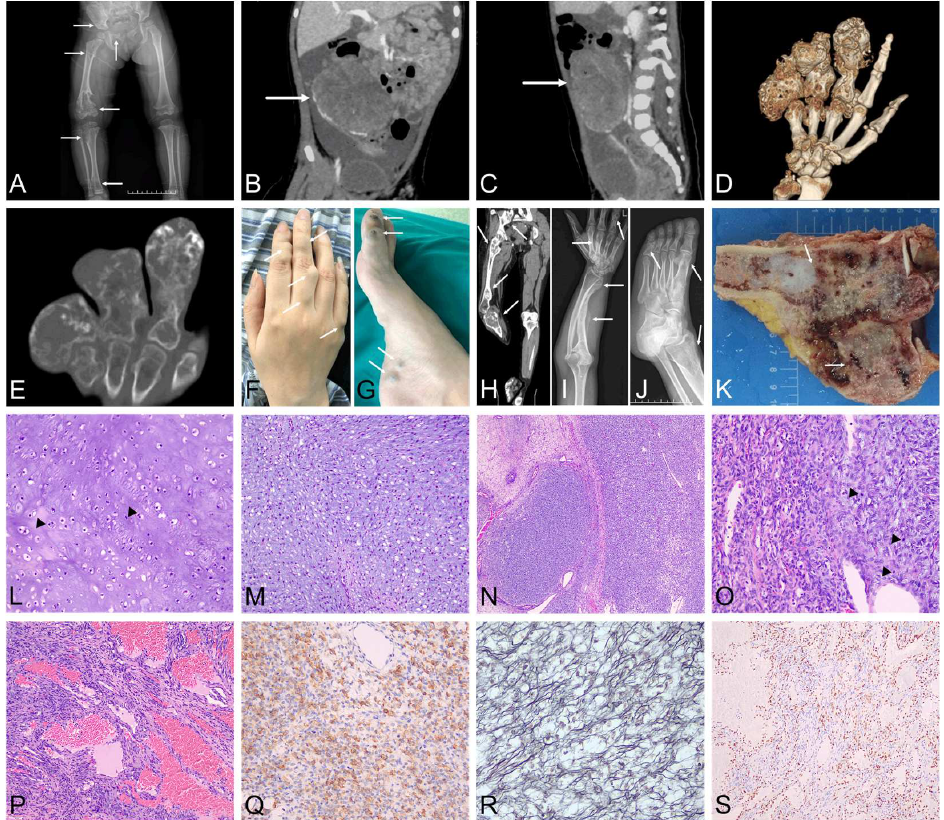
Figure 1. ( A ) Spotted bone destruction of the right upper femur, tibial metaphysis, iliac and pubis was shown by X-ray (arrow). ( B , C ) A huge soft tissue mass in pelvis could be observed from the MRI (arrow). ( D , E ) Multiple expansive bone destruction was shown in the right little finger; ring finger; middle finger; the third, fourth and fifth metacarpal bones; and the distal ulna by three-dimensional reconstruction and CT. ( F , G ) Multiple purplish blue subcutaneous nodules were found in the hands and feet, protruding on the surface of the skin (arrow). ( H ) Multiple bone destruction was seen in bilateral ilium, right acetabulum, left ischium, bilateral femur, right tibia, fibula and calcaneus by PET-CT (arrow, still image). ( I , J ) A curved deformity of the left radius and ulna, and eccentric low-density shadow of multiple short tubular bones of left hand and foot and the left distal tibia were presented by plain X-ray (arrow). ( K ) Well-differentiated hyaline cartilage (arrow, up) and dark red sticky area involving the surrounding soft tissue were seen in the cut section of the right proximal tibial tumour (arrow, down). ( L ) Active chondrocytes were distributed in clusters, and atypical binucleate cells (arrow) could occasionally be seen (Hematoxylin-eosin staining, × 200). ( M ) Chondrocytes with severe atypia could be demonstrated in the sarcomatous area, no more cartilage lacunae could be found (Hematoxylin-eosin staining, × 100). ( N ) Lobular-patterned ovarian sex cord-stromal tumour with mucinous degeneration was seen at low power (Hematoxylin-eosin staining, × 40). ( O ) The tumour cells had obvious nucleoli and light eosinophilic cytoplasm, and mitotic figures (arrow) were easy to find at high power (Hematoxylin-eosin staining, × 200). ( P ) Solid spindle cell and cavernous haemangioma-like areas of Maffucci syndrome (Hematoxylin-eosin staining, × 100). ( Q ) Positive immunoreaction with α-inhibin was seen in the cytoplasm in ovarian tumour (EnVision, × 200). ( R ) Reticular fibres were confirmed in the ovarian sex cord-stromal tumour (Reticular fibre staining, × 200). ( S ) Positive immunoreaction with ERG was observed in the nucleus of the haemangioma (EnVision, × 100).